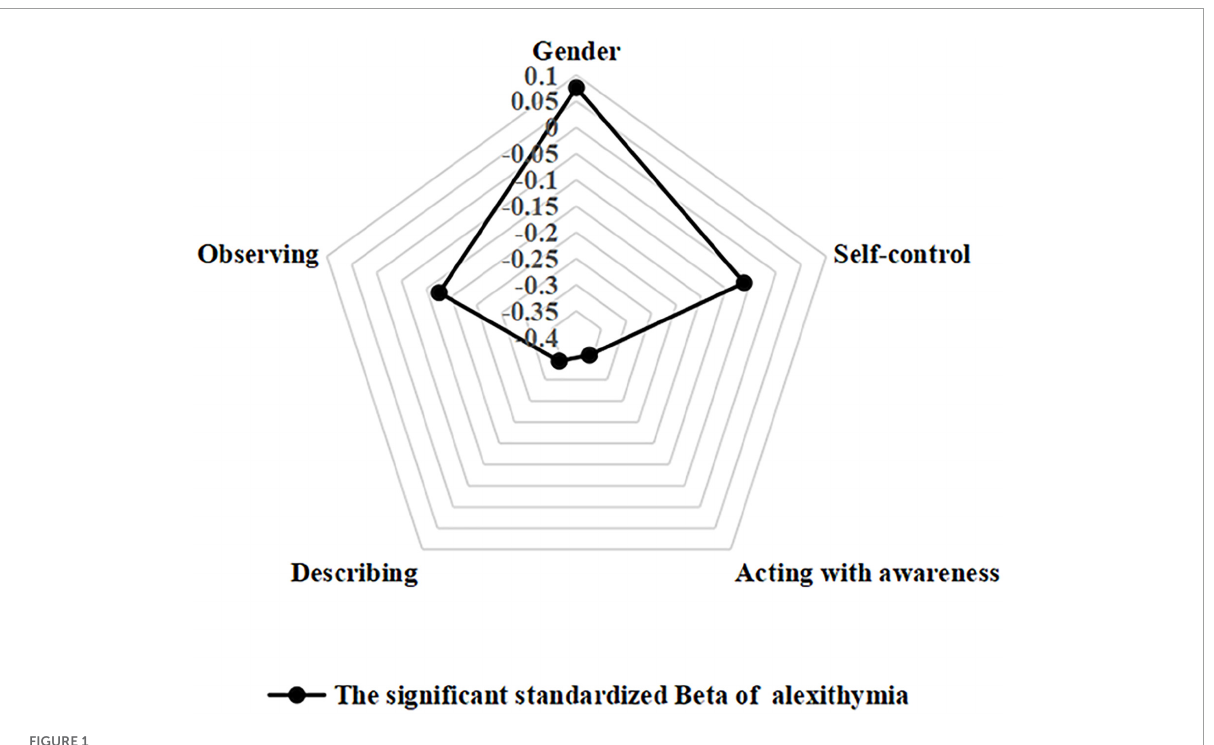
FIGURE1 Radar chart of alexithymia among medical